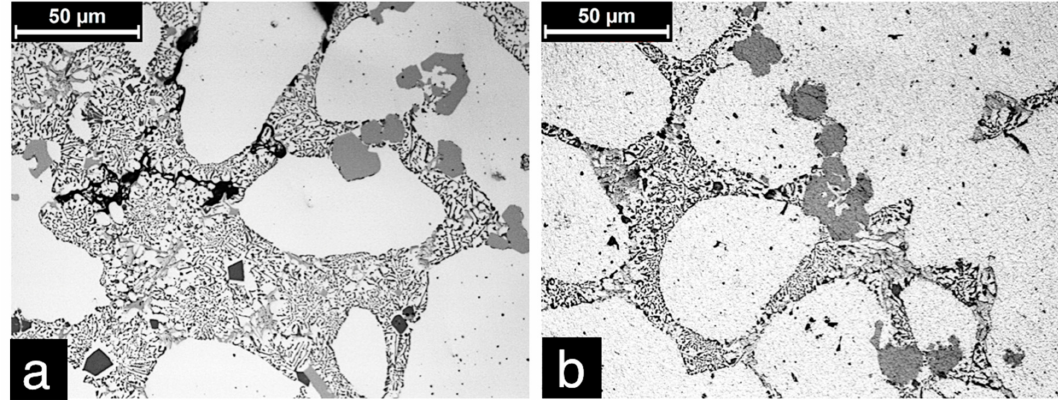
Figure 12. Al 15 (FeMnCr) 3 Si 2 particles in the B319+Fe alloy after heat treatments using two extreme combinations of temperature and soak time: 575 ◦ C-0 s ( a ) and 595 ◦ C-90 s ( b